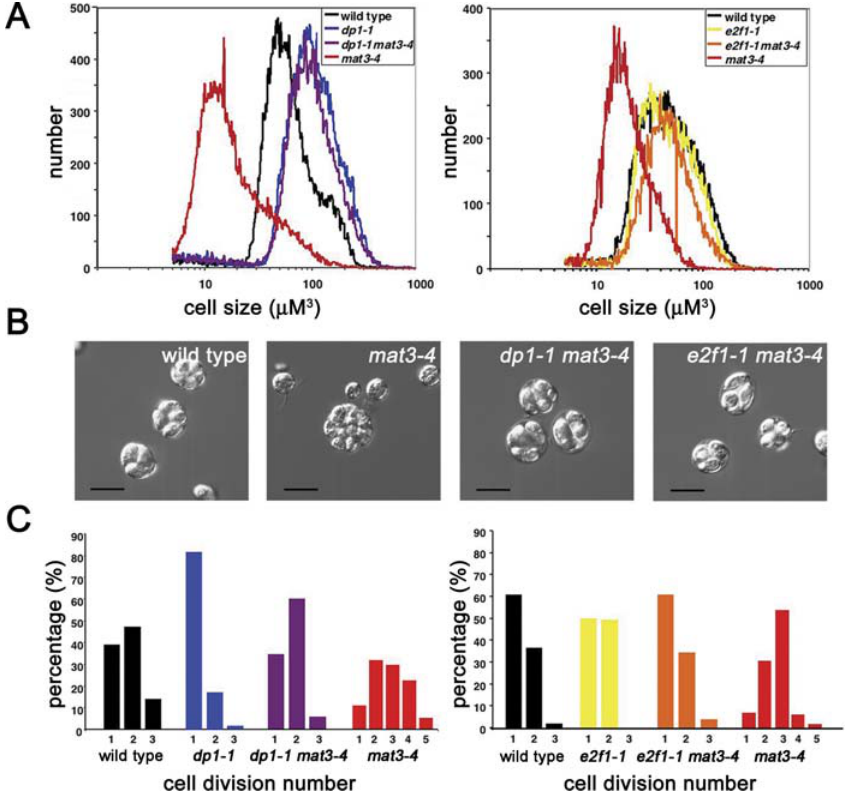
Figure 2. e2f1 and dp1 Mutations Suppress mat3–4 Cell Division Phenotypes (A) Cell size distributions of dark-shifted cultures from indicated strains. (B) Nomarski images of postmitotic clusters from indicated strains. Scale bar ¼ 10 l m. (C) Distribution of cell division numbers from dark-shifted post-Commitment cells of indicated genotype. DOI: 10.1371/journal.pgen.0020167.g002